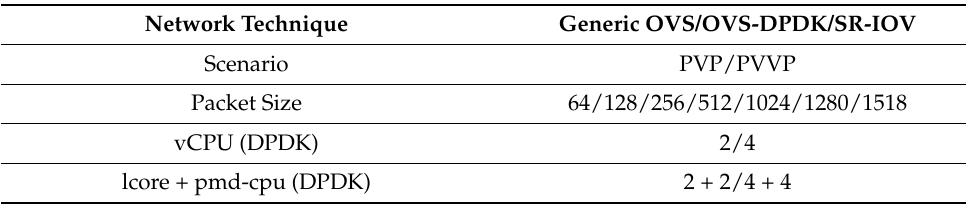
Table 3. Experimental settings in performance